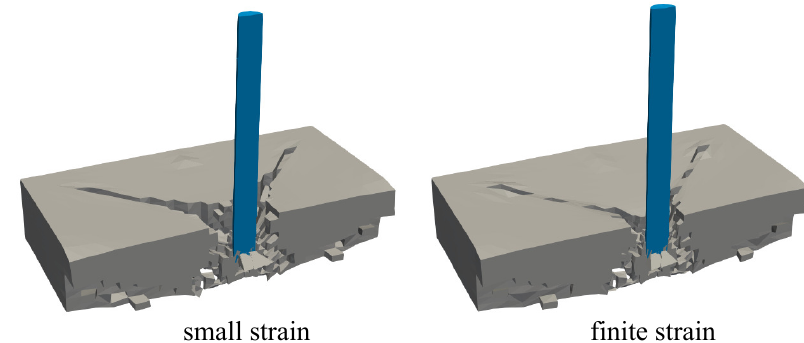
Figure 20. Cross-section view of damaged plate for small and finite strain